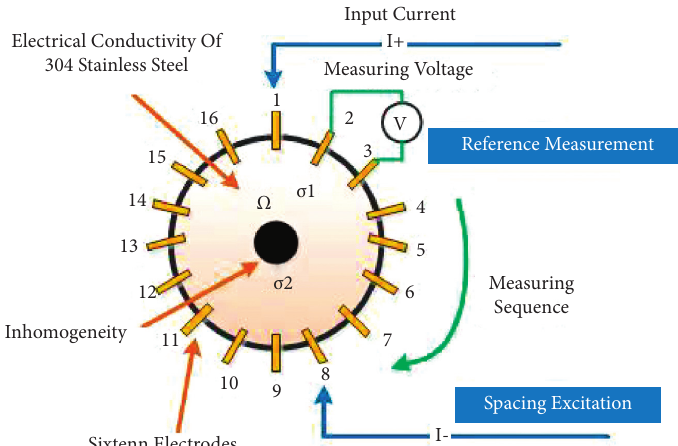
Figure 3: Two-dimensional illustration of the heterogeneous body problem in electrical impedance